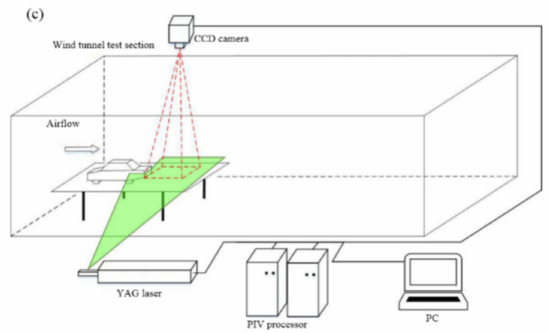
Figure 2. PIV measurements in three orthogonal planes: ( a ) y–z planes; ( b ) x–z planes; and ( c ) x–y